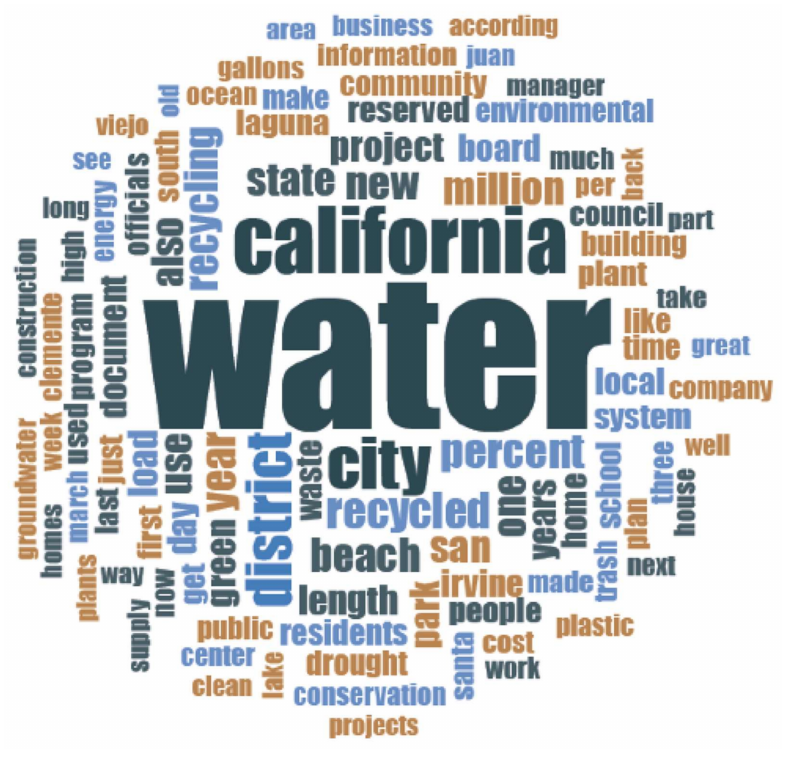
Figure 3. Orange County Register : terms associated with potable water